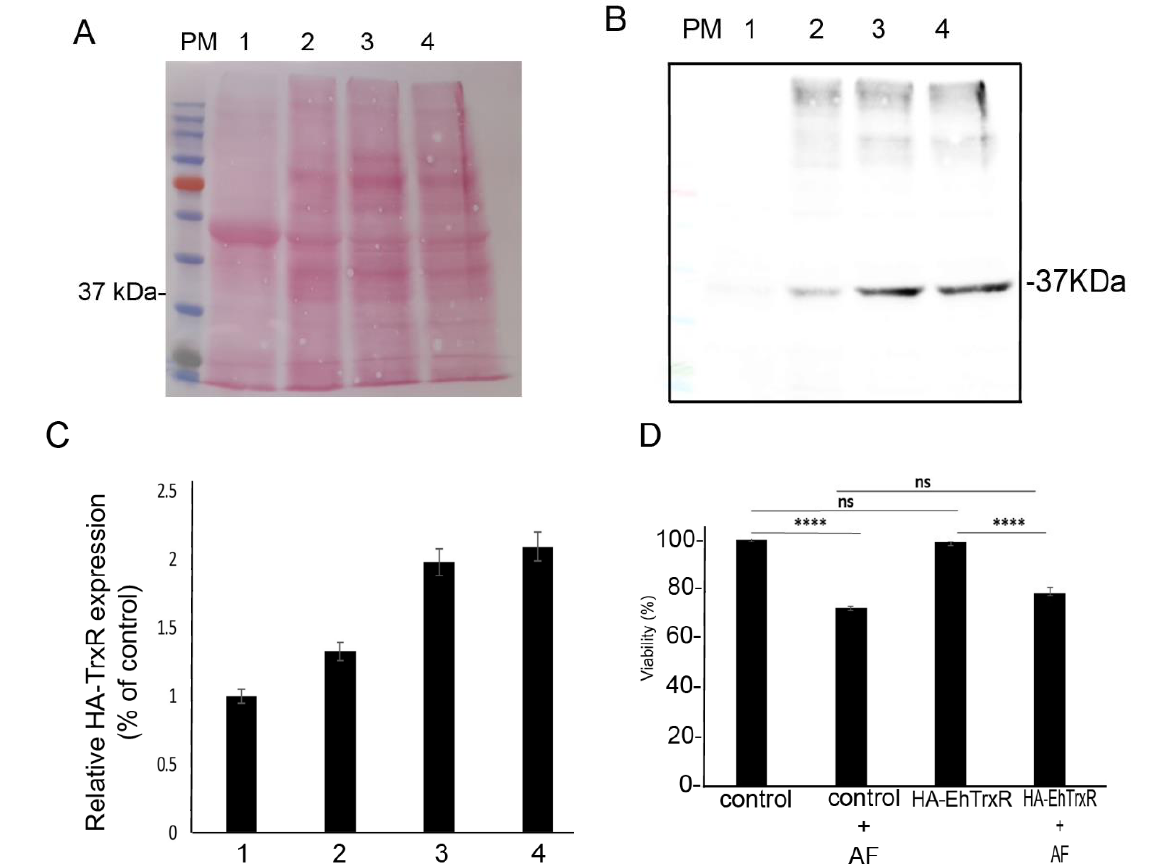
Figure 6. Western blot analysis of E. histolytica trophozoites that overexpress a hemagglutinin (HA)-tagged EhTrxR and viability assay. Legend: Protein molecular weight marker (PM). Control trophozoites (lane 1). HA-tagged EhTrxR troph- ozoites cultivated in the presence of an increasing concentration of G418 (lane 2: 6 µg/mL, lane 3: 30 µg/mL, lane 4: 48 µg/mL). ( A ) Ponceau staining of a nitrocellulose membrane containing cytosolic proteins (40 µg) separated by SDS PAGE of control trophozoites and of HA-tagged EhTrxR trophozoites cultivated in the presence of an increasing concentration of G418. ( B ) Immunodetection of (HA)-tagged EHTrxR with an HA monoclonal antibody (1:500) in HA-tagged